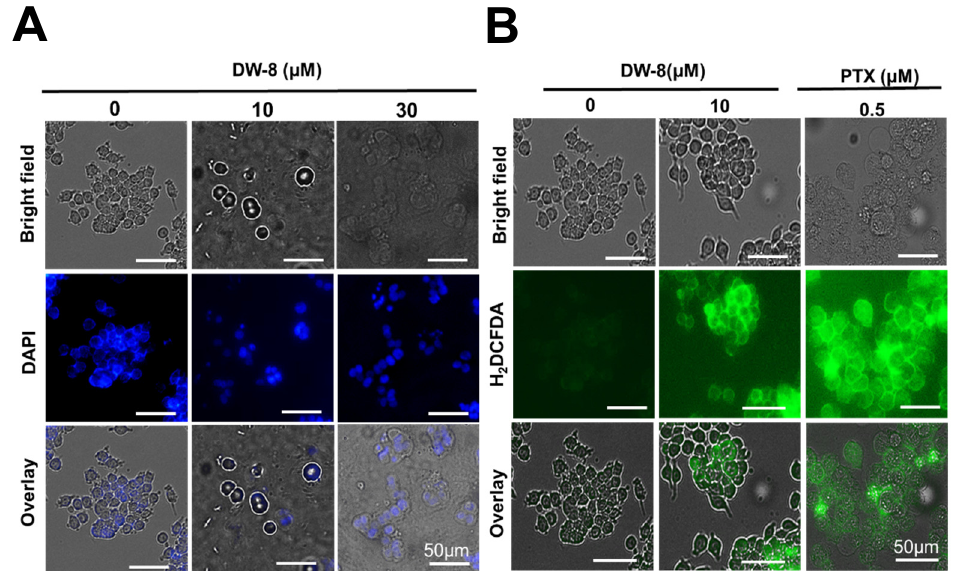
Figure 4. ( A ) The effect of the incubation of SW620 cells with the vehicle (0 µ M), 10 and 30 µ M of DW-8 , followed by DAPI, on cell nuclear morphology. The nuclei of the cells incubated with the vehicle were circular and intact, whereas the nuclei of cells incubated with 10 and 30 µ M of DW-8 were shrunken and fragmented. ( B ) The effect of vehicle (0 µ M DW-8 ), 10 µ M of DW-8 and 0.5 µ M of paclitaxel (PTX) on the fluorescence level of the compound DCFDA, due to the biotransformation of H 2 DCFDA by cellular esterases. The level of green fluorescence and thus, the levels of ROS, produced by DW-8 and paclitaxel, was significantly greater ( p -value < 0.0001) than the negative control. The data represent the means ± SD of two independent